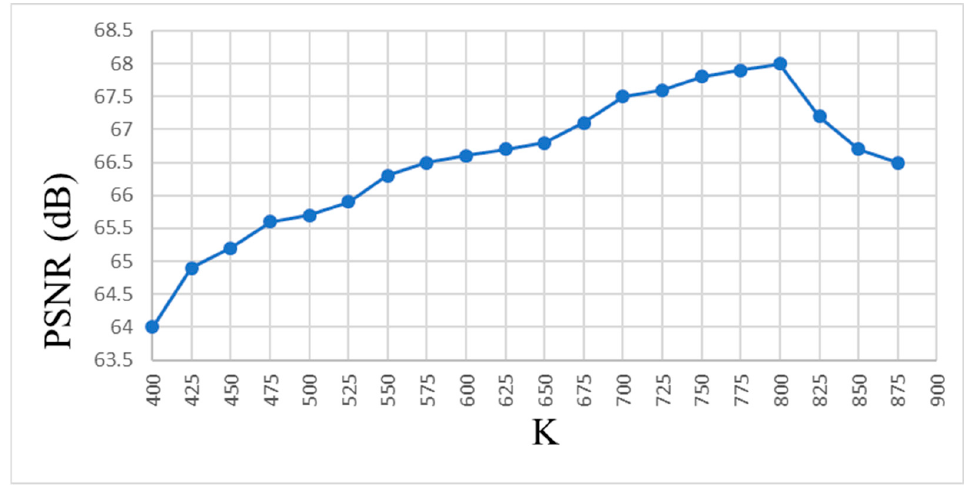
Figure 2. Peak signal-to-noise ratio (PSNR) vs. number of clusters K.